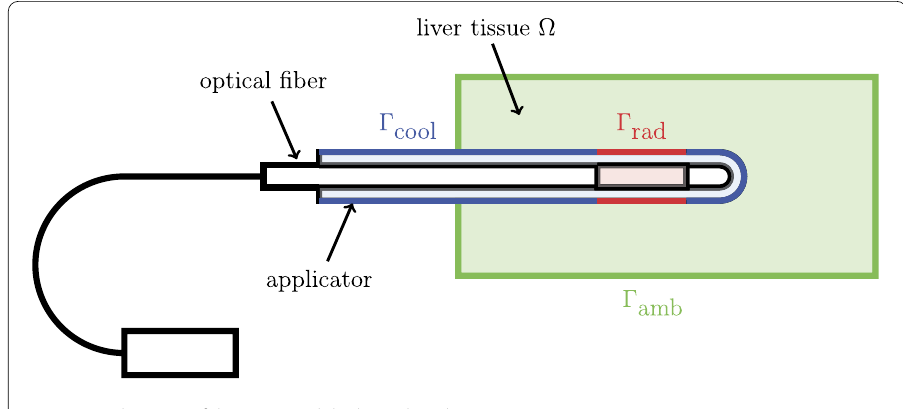
Figure 1 Schematic of the setup and the boundary